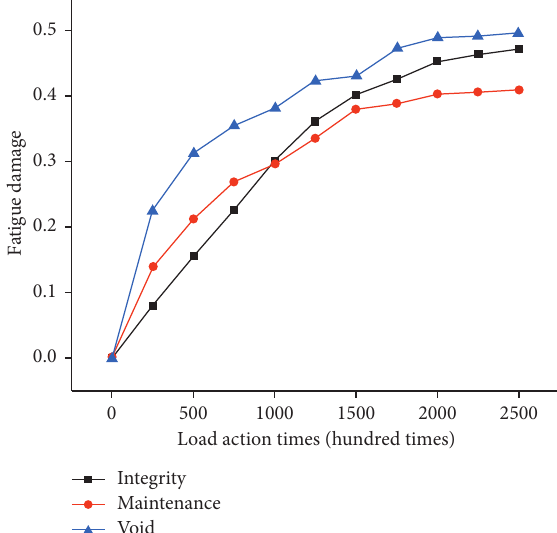
Figure 20: Cumulative evolution of fatigue damage under three working conditions under 1.2MPa tire pressure.